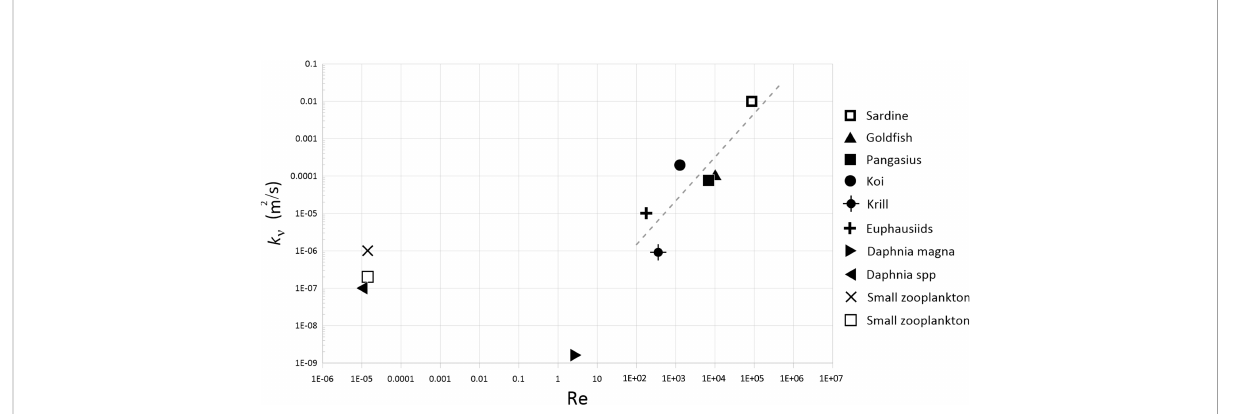
FIGURE 13 Eddy diffusivities associated with aquatic species having different Reynolds numbers based on the cruise speed. The broken line is a least- squares linear regression fi tted to the data with Re > 100.